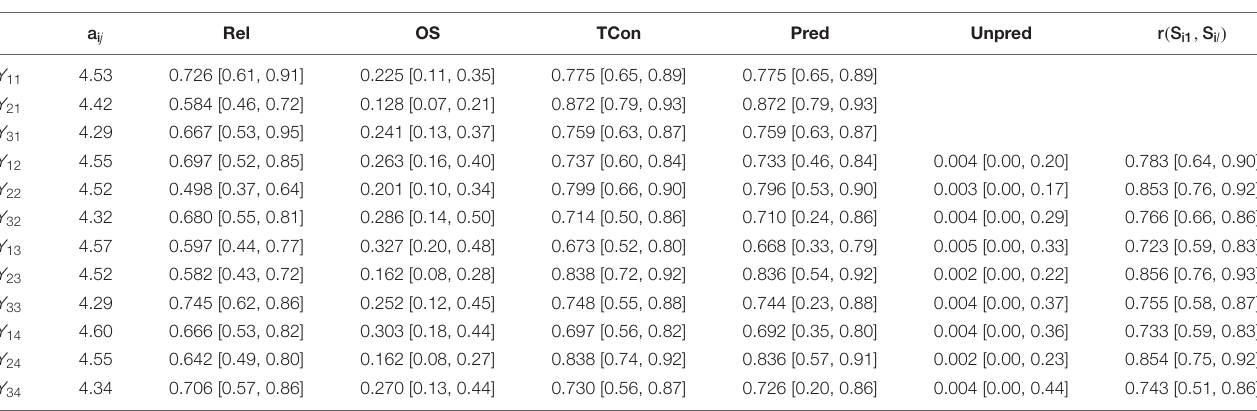
TABLE 2 | Results of the LST-AR model of parents’